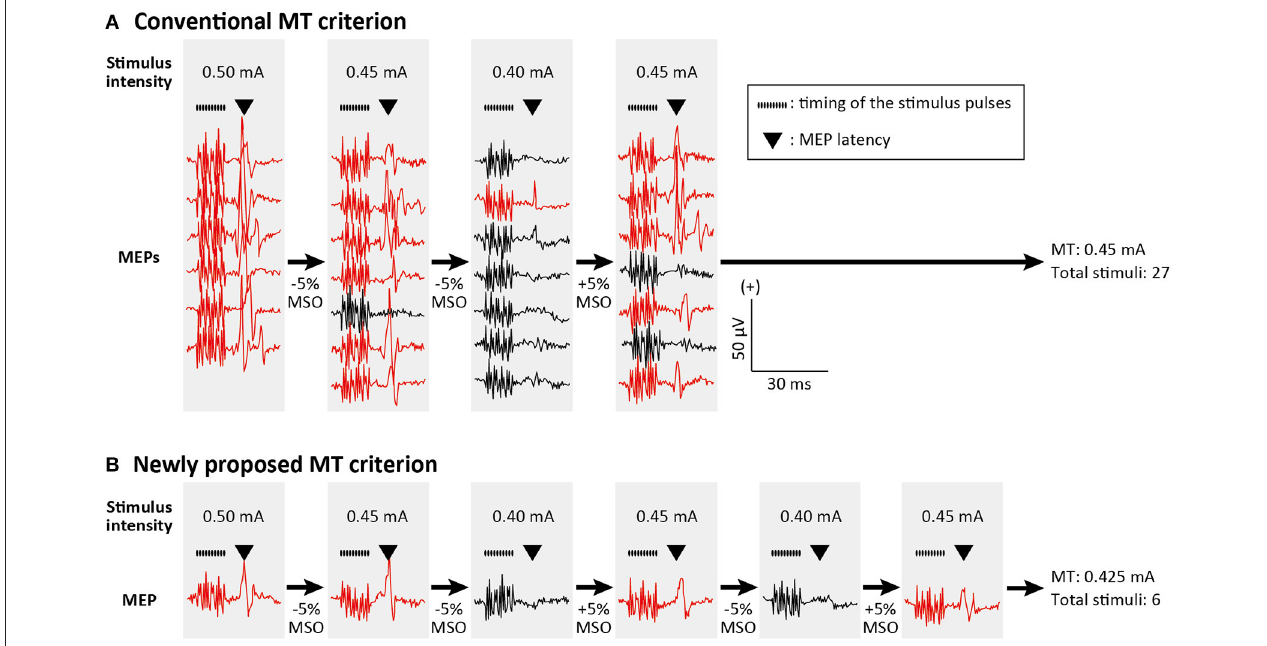
FIGURE 2 | Conventional and newly proposed criteria for motor threshold (MT) estimation. MT estimation procedure in a single stimulating channel is depicted. MEPs greater and smaller than the predetermined amplitude are illustrated with red and black traces, respectively. Train of the black dots and triangle above the MEP traces indicate the timing of stimulus pulses and MEP latencies, respectively. (A) According to the conventional criterion, MT was defined as the lowest stimulus intensity capable of evoking MEPs greater than the predetermined amplitude (e.g., 50 µ V) in at least five of 10 consecutive trials (in the figure only 7 trials are shown). If more than five significant or non-significant MEPs had been observed while fewer than 10 stimuli were delivered, the next stimulus intensity was decreased or increased by 5% of the maximum stimulator output (MSO). (B) In the newly proposed criterion, the next stimulus intensity was decreased or increased by 5% of the MSO if the actual MEP was larger or smaller than the predetermined amplitude, respectively. As the MT we defined the mean stimulus intensity of the last two stimuli if the intensity changes in the last five stimuli were within ± 5% of the